Question: Give a one-sentence summary of this figure.
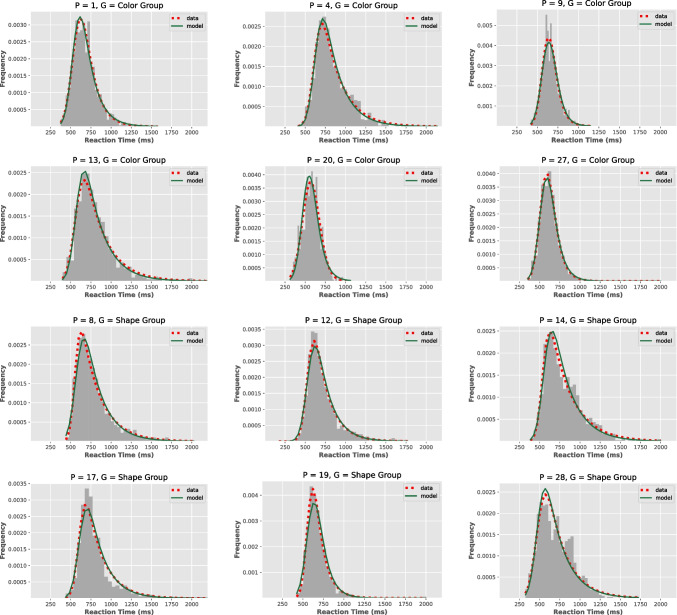
Answer: Ex-Gaussian distributions of 12 participants’ reaction times. Best model-free fits to the data are shown in red and model-predicted distributions are shown in green. This figure is an expansion of Fig. 5 . “P” is participant number and “G” is group membership which is be either “color” or “shape” based on the participant’s learning experience. Note that all versions of the model are equally good in predicting the distributions